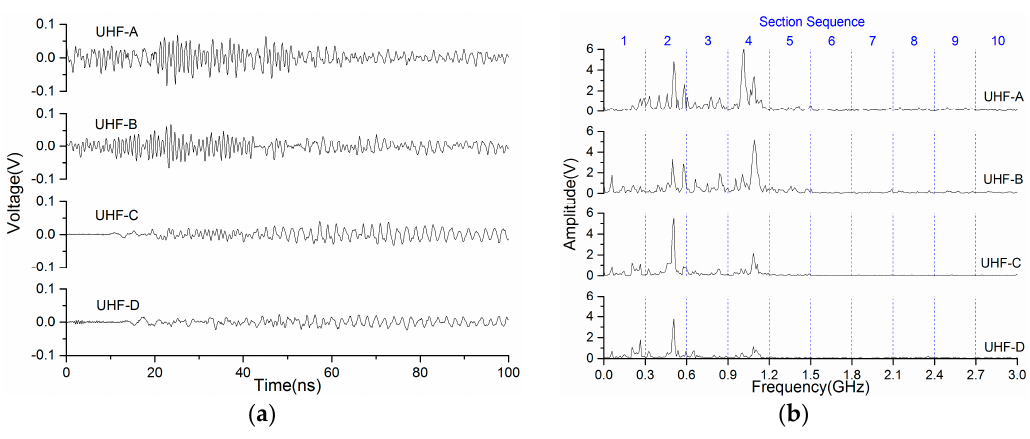
Figure 2. UHF signals acquired by four sensors: ( a ) time domain; and ( b ) frequency domain.